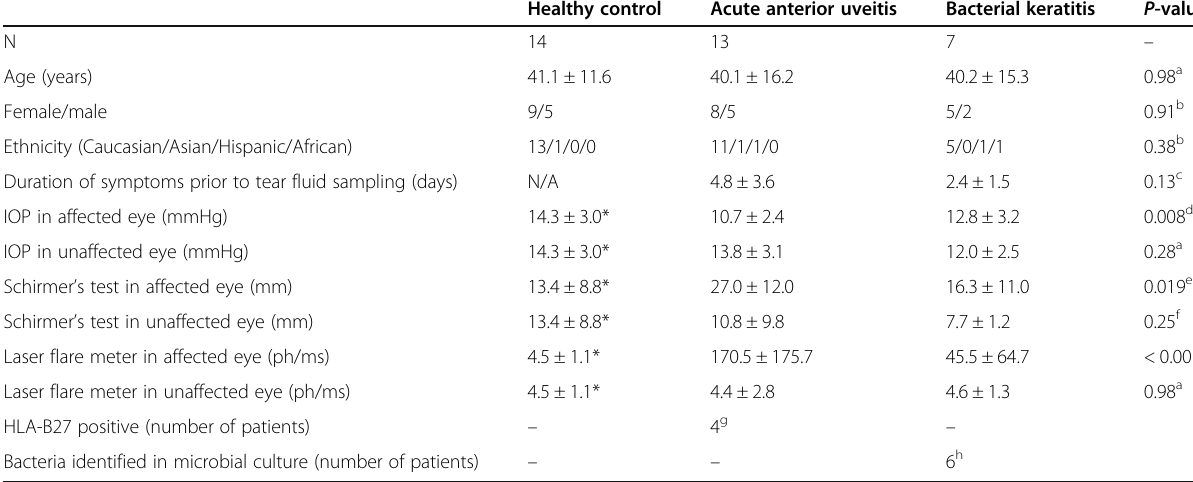
Table 1 Patient